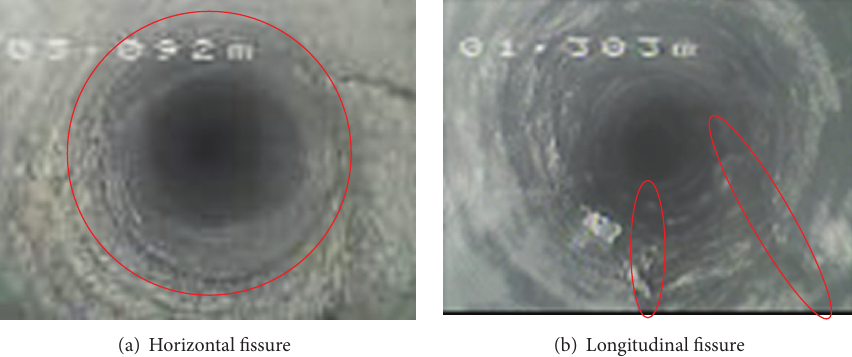
Figure 3: Main fissures emerged initially after